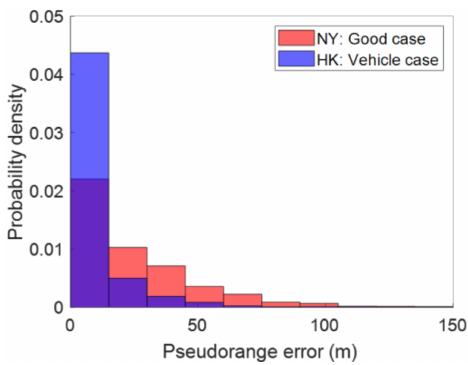
Figure 10. Probability density function plot on pseudorange error labelled by double differencing technique. Note that the master satellite is excluded from pseudorange error labelling, e.g., i (cid:54) = m in Equation